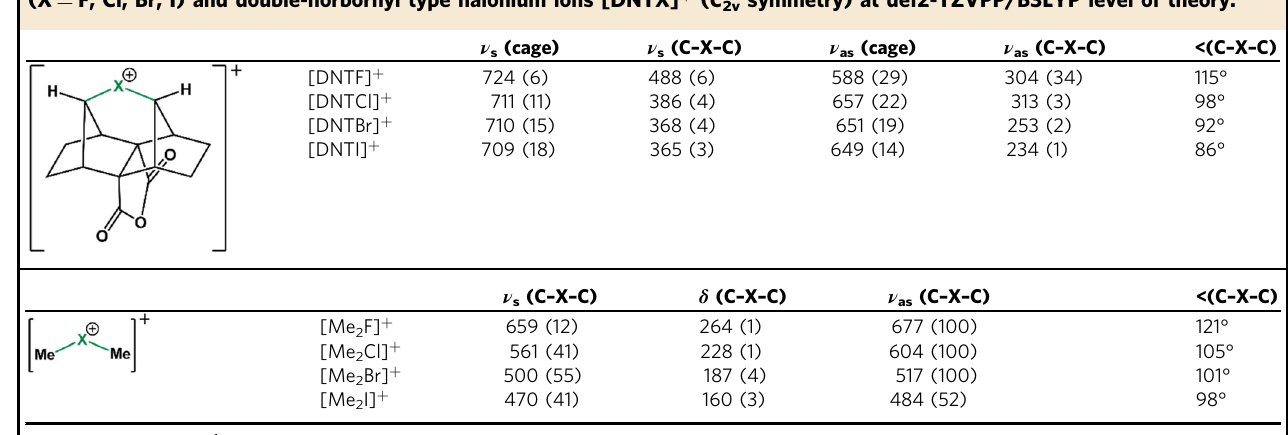
Table 1 Comparison of selected computed vibrational frequencies and C – X – C bond angles of dimethyl halonium ions [Me 2 X] + (X = F, Cl, Br, I) and double-norbornyl type halonium ions [DNTX] + ( C 2v symmetry) at def2-TZVPP/B3LYP level of